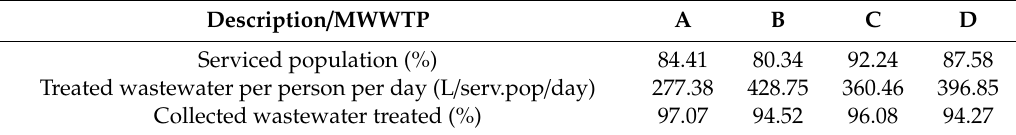
Table 4. Service level